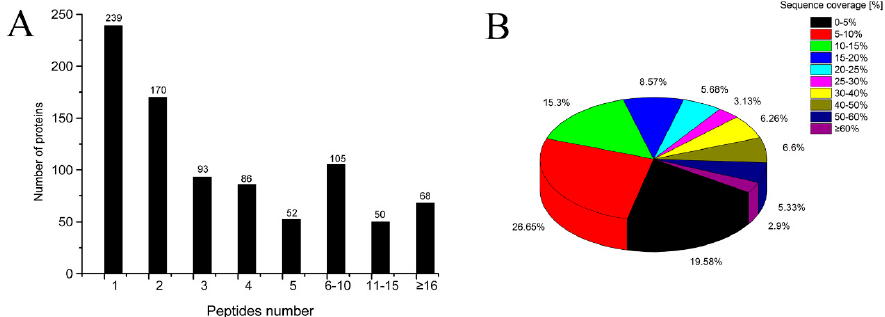
Figure 1. ( A ) Number of peptides matched to proteins; and ( B ) percentages of sequence coverage of proteins by identified peptides.